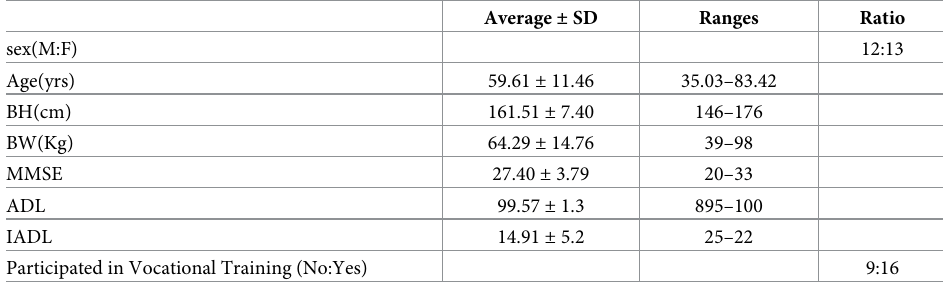
Table 1. Demographics of the